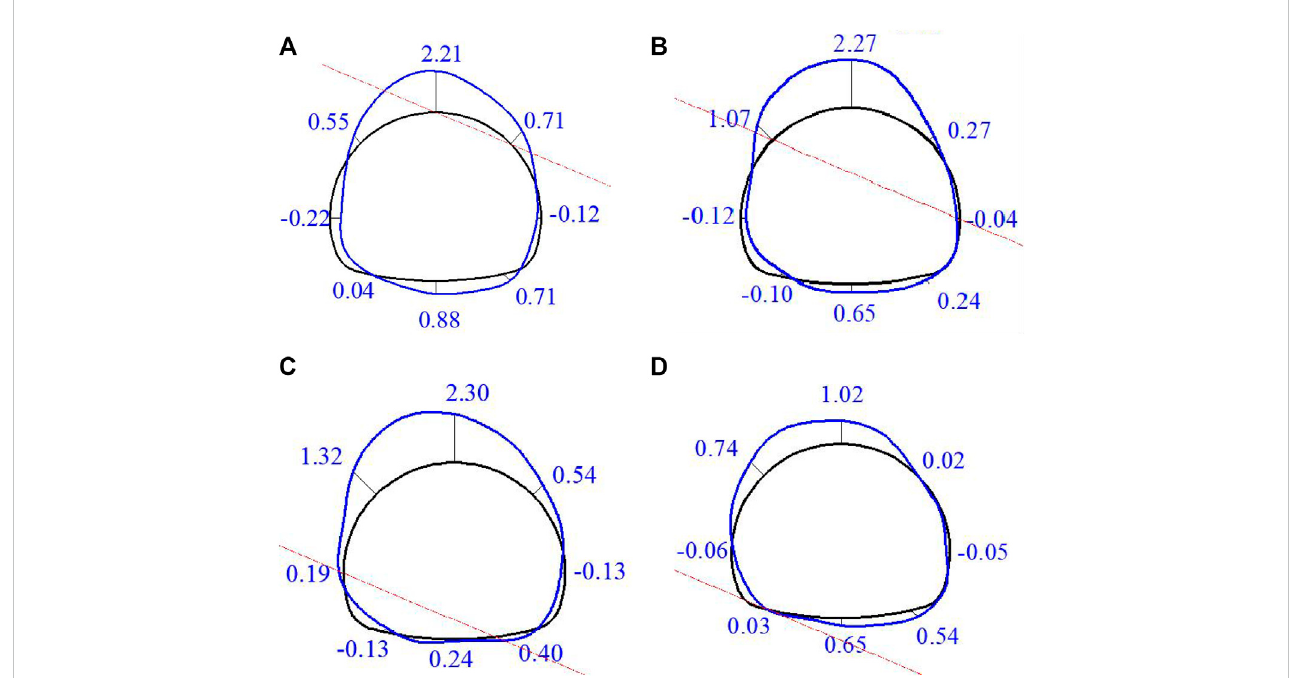
FIGURE 19 First principal stress of secondary lining under four different conditions (unit: MPa): (A) Tunnel vault crossing the soil – rock interface; (B) Arch haunch crossing the soil – rock interface; (C) Arch spring crossing the soil – rock interface; and (D) Wall foot crossing the soil – rock interface.